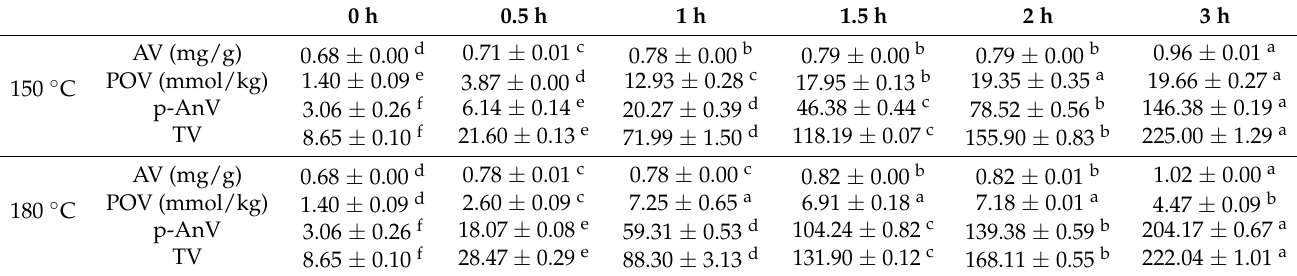
Table 2. Changes in AV, POV, p-AnV and TV of SBO&SSO oil blend during heating.